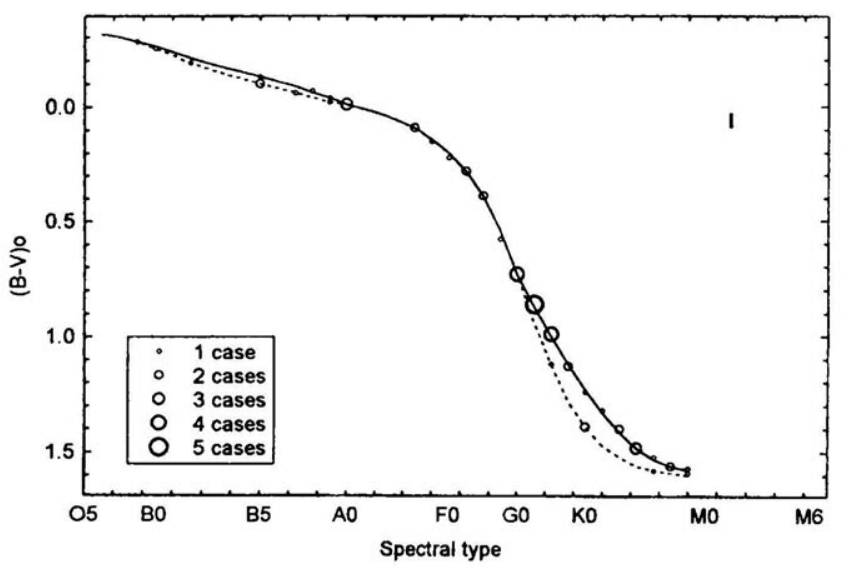
Fig. 12. Intrinsic color indices (ß-V)o for luminosity I stars: the solid line is for lb and the broken line is for Ia+Iab luminosity